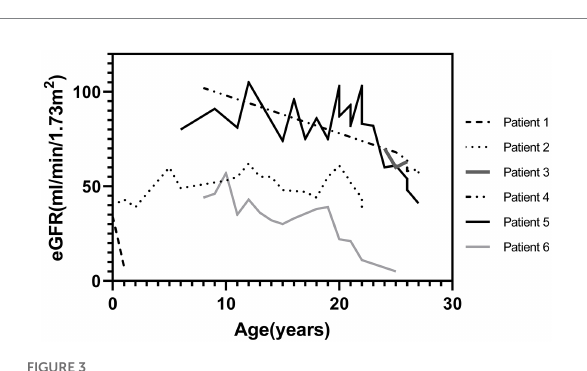
FIGURE 3 Change of eGFR of six patients with kidney impairment at the last follow-up (Bartter syndrome type 3: patient 2, 3, 5, 6). eGFR, estimated glomerular filtration rate [calculated using the bedside Schwartz equation for children and CKD-EPI equation for adults]; Kidney impairment, defined as an eGFR cr < 60 mL/min/1.73 m 2 . No variants were found in patient 1 and